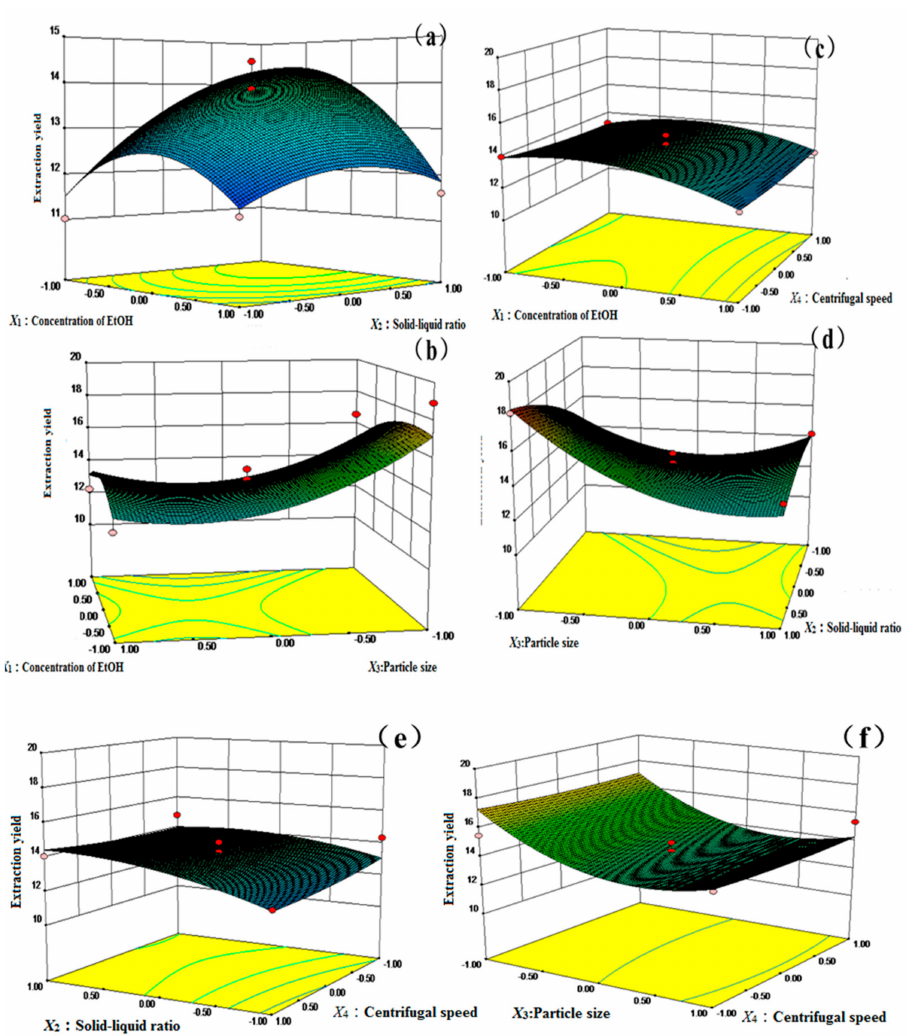
Figure 4. Response surface plots showing the e ff ects of variables on the total extraction yield of seven compounds from Psoralea Fructus ; ( a ) X 1 and X 2 ; ( b ) X 1 and X 3 ; ( c ) X 1 and X 4 ; ( d ) X 2 and X 3 ; ( e) X 2 and X 4 ; ( f ) X 3 and X 4